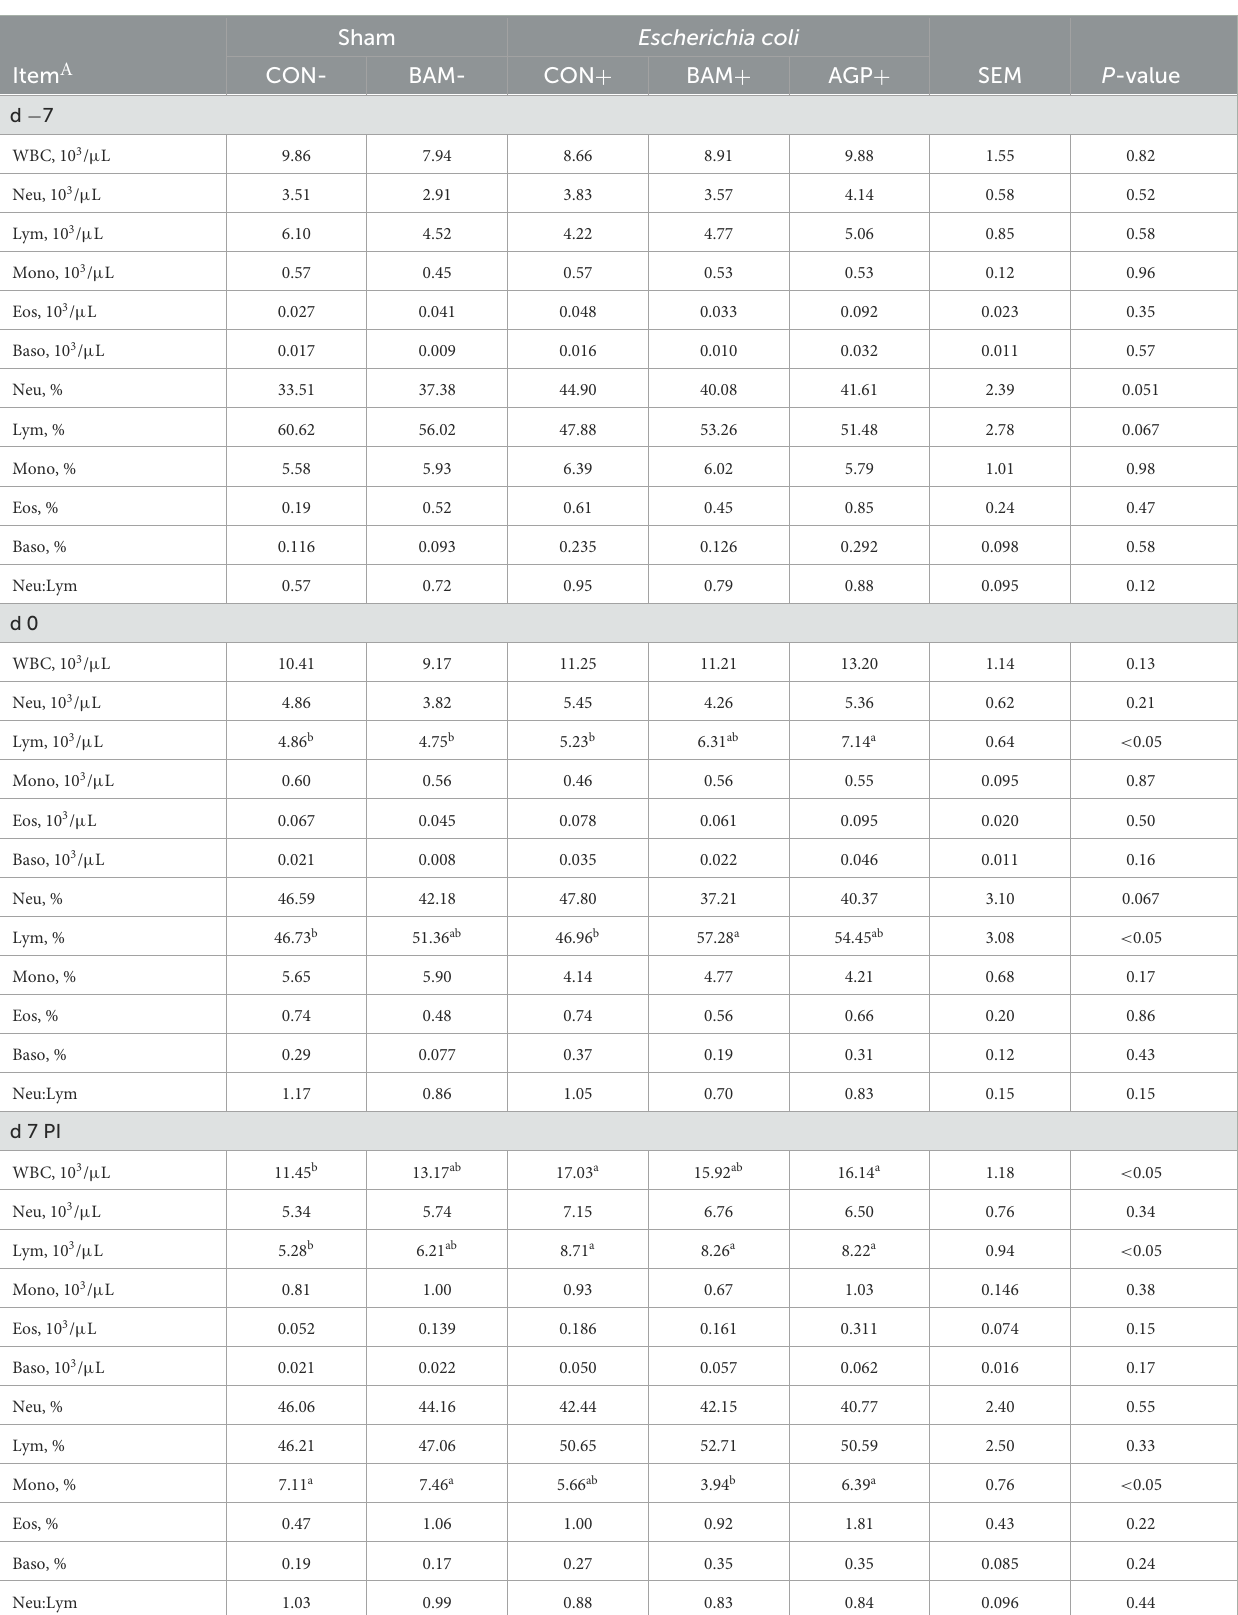
TABLE 3 Total and differential white blood cells in weaned pigs a fed control (CON) diet or diets supplemented with Bacillus amyloliquefaciens (BAM) or antibiotics (AGP).